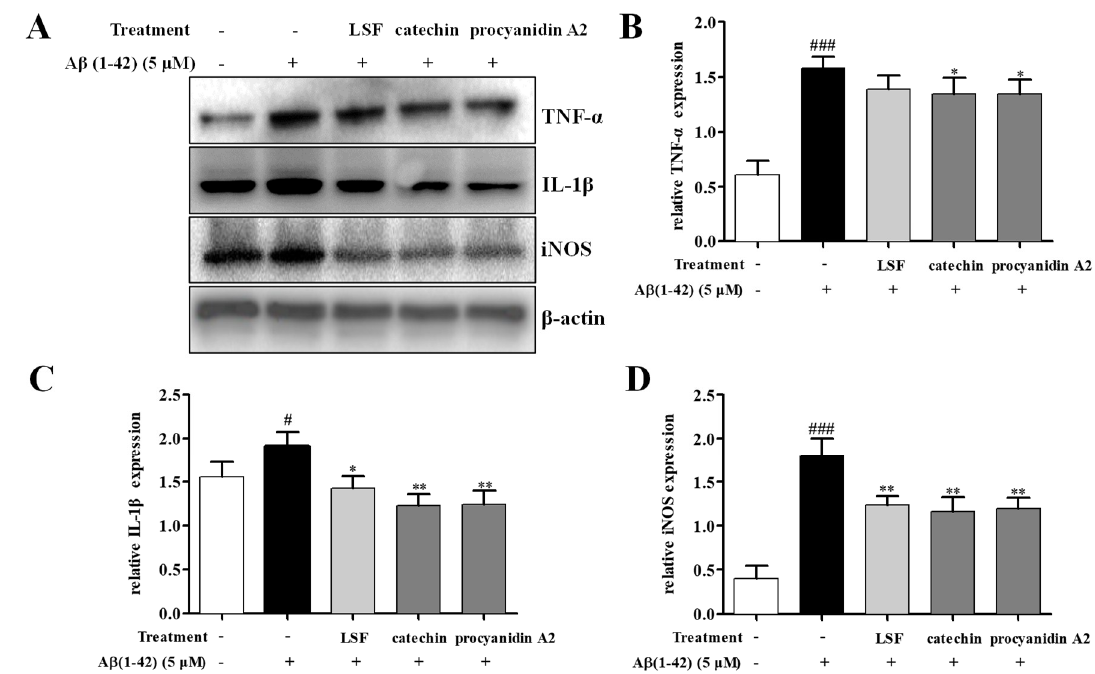
Figure 5. The protein expressions of TNF- α , IL-1 β , and iNOS in A β (1-42)-induced BV-2 cells under the treatments of LSF (0.469 µ g/mL), catechin (10 µ M), and procyanidin A2 (10 µ M). BV-2 cells were pretreated with 5 µ M A β (1-42) for 12 h, followed by incubations of LSF, catechin, and procyanidin A2 for another 12 h. ( A ) After treatment, cell lysates were harvested and subsequently employed for TNF- α , IL-1 β , and iNOS measurements using Western blotting. Band intensities of TNF- α ( B ), IL-1 β ( C ), and iNOS ( D ) were quantified using Image J software and normalized to β -actin. Bars are representatives of three independent experiments. BV-2 cells treated with medium alone were set as the control group, and BV-2 cells treated with 5 µ M A β (1-42) alone were set as the A β group. # p < 0.05, ### p < 0.001 vs. control group; * p < 0.05, ** p < 0.01 vs. A β group. The full-length Western blotting images are shown in Figure S8.